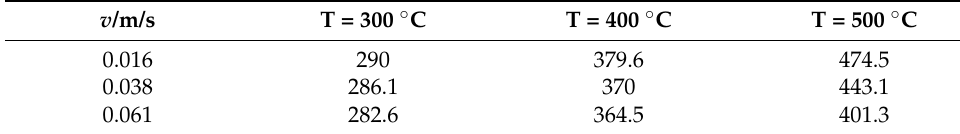
Table 1. Temperature of point B when the assembly is completed ( ◦